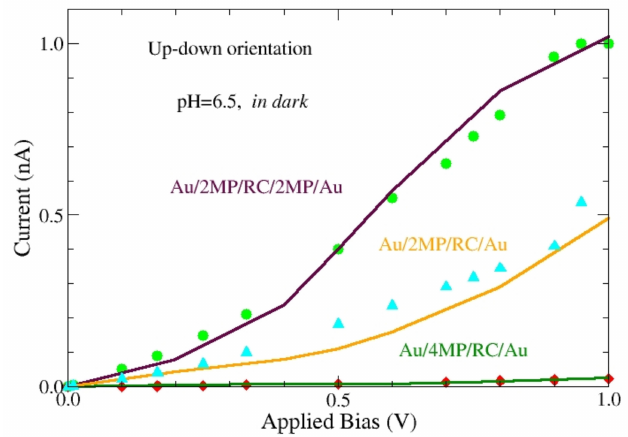
Figure 8. I - V characteristics of b RC in dark and in light for a range of applied bias of interest for experiments, Φ = 0.219eV. The contacts are in the up-down orientation. Calculations are performed by using three different values of ρ max = 2.7 × 10 12 Ω Å, (red diamonds), ρ max = 2.7 × 10 11 Ω Å (cyan triangles), and ρ max = 5.4 × 10 10 Ω Å (green circles). All the calculations assume ρ min = 2.7 × 10 4 Ω Å and Φ = 0.219 eV. Continuous lines refer to experimental data from [12] obtained by using samples in which the protein was sandwiched between differently modified electrodes as reported in the